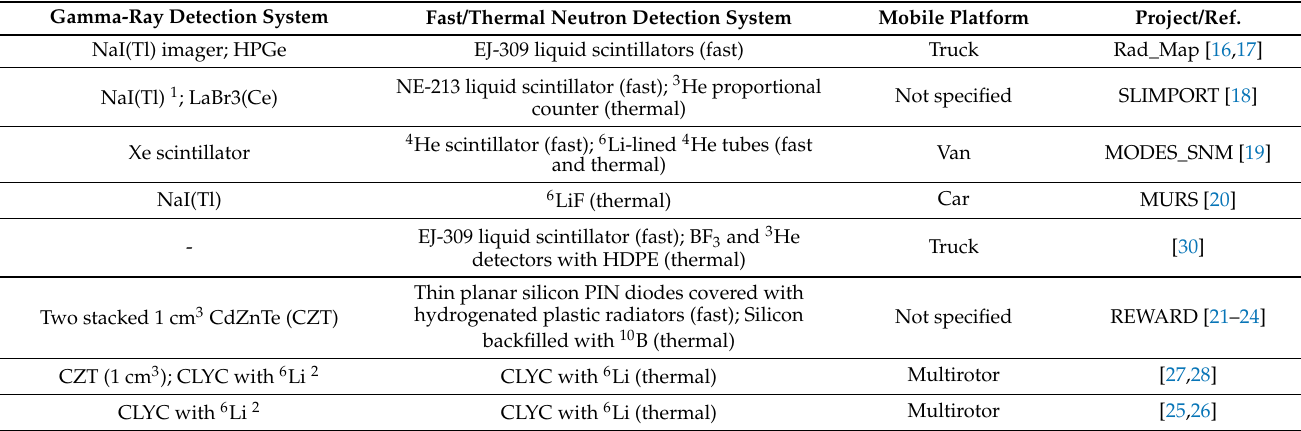
Table 1. Combination of mobile radiation detection systems used in security